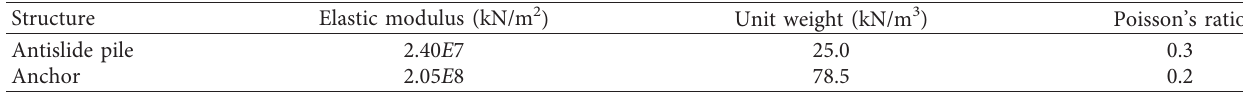
Table 3: Mechanical parameters of the support structures.